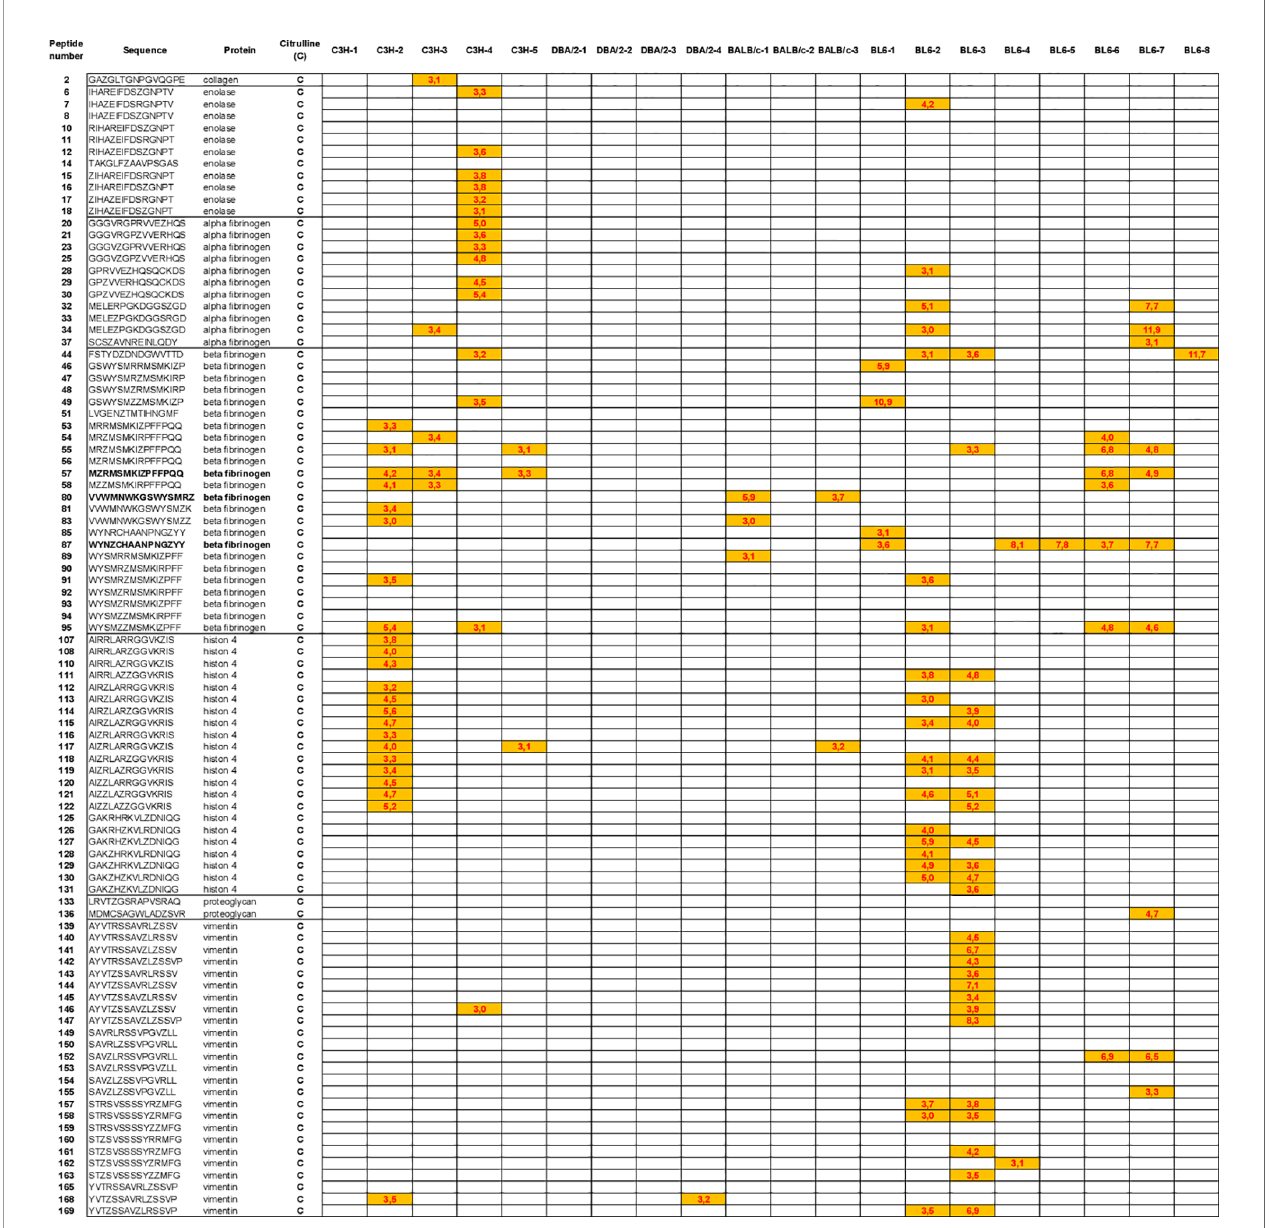
FIGURE 6 | Autoantibody pattern speci fi c for citrullinated peptides after hPAD4 immunization. Peptides recognized by hPAD4 immunized mice and no PBS immunized mice were identi fi ed. A ratio test/background was calculated for each arginine and citrulinated peptide. Speci fi c IgG response to citrullinated peptide was de fi ned by a ratio higher than 3 for citrullinated peptide and by a ratio lower than 3 for its arginine-substituted variant (orange